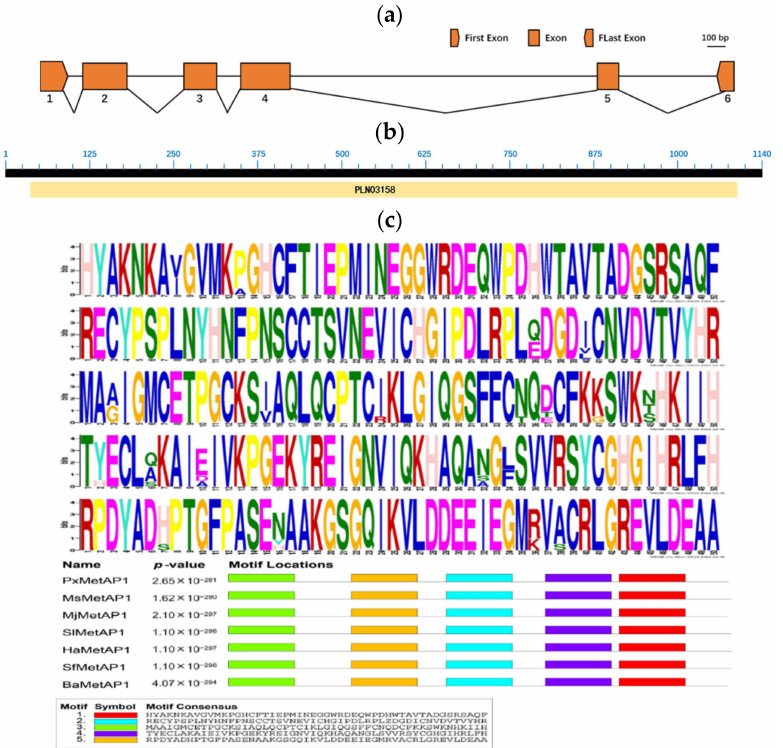
Figure 2. Structure and features of the PxMetAP1 gene in the G88 strain. ( a ) Genomic structure of the PxMetAP1 gene in P. xylostella . Exons are denoted by orange boxes, and introns are denoted by spaces between two boxes. The scale bar that corresponds to the figure’s scale is displayed; ( b ) annotation of the deduced PxMetAP1 protein sequence using the NCBI conserved domain database (CDD). The sequence was recognized as a distinctive member of the superfamily of methionine aminopeptidases (MetAPs); ( c ) illustration of the five motifs found in the PxMetAP1 gene. The figure above shows the amino acid frequency diagram of the PxMetAP1 gene, while the figure below shows the locations of the motifs in the PxMetAP1